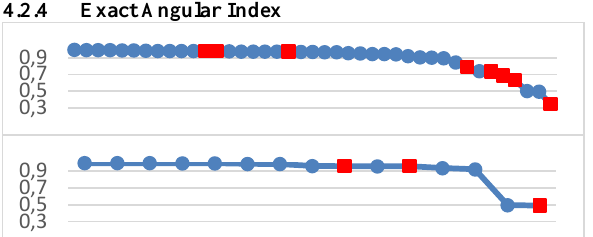
Figure 5: Exact Angular Index Scores for a simple (top) and a complex (bottom) region Within the simple region, the Exact Angular Index (Figure 5) identified 33 true positives (89%) [8 FP, 4 FN], and within the complex region, 12 true positives (71%) [3 FP, 5 FN]. Contrary